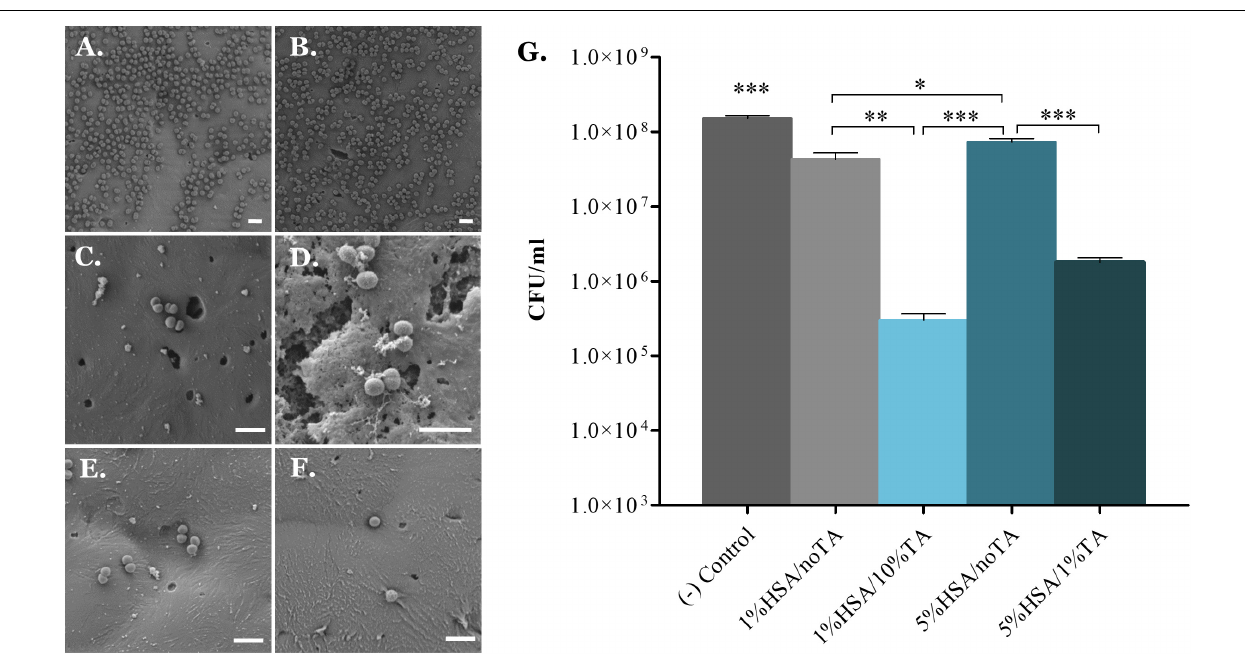
FIGURE 5 | 3D in vitro evaluation of antibacterial effectiveness of coated scaffolds against S. aureus in suspension. (A,B) Uncoated scaffolds showed extensive bacterial colonization by S. aureus , while (C,E) scaffolds coated with 1% and 5%HSA showed significantly fewer adherent bacteria on the surfaces. Scaffolds coated with 1% and 5%HSA and stabilized with 10% and 1%TA, respectively, (D,F) did not only evidenced reduced bacteria colonization, but also showed morphological changes on the bacterial membrane suggesting possible membrane disruption. (G) Number of viable colony forming units of S. aureus recovered from the scaffolds surface. Data shown as mean ± SD, n = 6. ( ∗ p < 0.05, ∗∗ p < 0.01, ∗∗∗ p < 0.001); scale bars: 2 µ